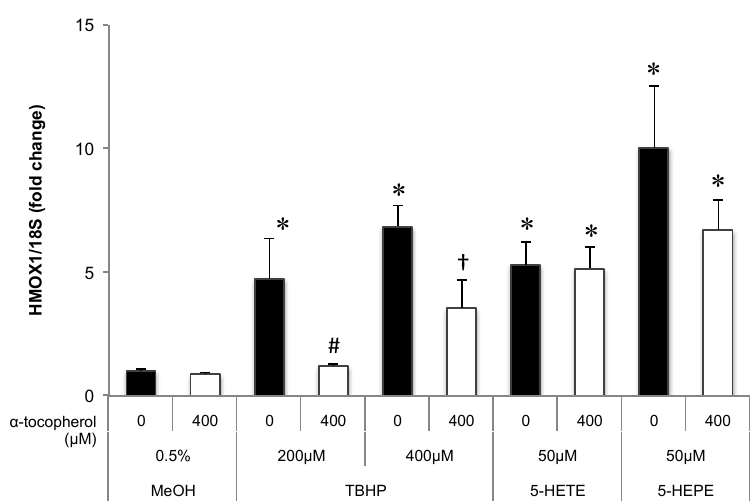
Figure 4. Effects of antioxidant treatment on HMOX1 upregulation by hydroxy fatty acids in HUVECs. Cells were pretreated with 400 µ M α -tocopherol for 1 h; subsequently, 0.5% MeOH, 200 µ M TBHP, 400 µ M TBHP, 50 µ M 5-HETE, or 50 µ M 5-HEPE was added. After incubation with each sample